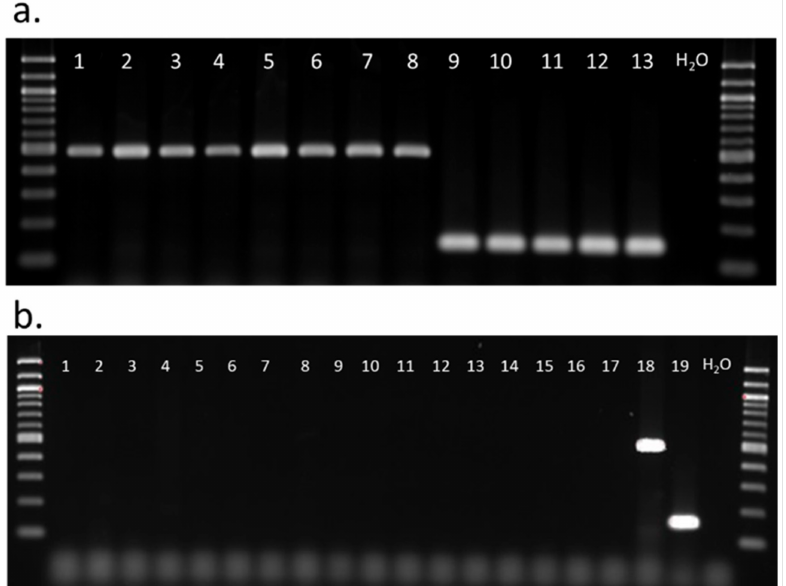
Figure 4. ( a ) Diagnostic polymerase chain reaction for DNA sequence-based identification of specimens of the S. festinus genotype from California (lanes 1–8) and the Southeastern United States (lanes 9–13). ( b ) Specificity of the diagnostic PCR against other Membracidae (lanes 1–4), Cercopidae (lanes 5–6), Fulgoroidea (lanes 7–8), Cicadellidae (lanes 9–14), Aphididae (lane 15), Aleyrodidae (lane 16), and Psylloidea (lane 17) compared to the S. festinus genotype from California (lane 18) and the Southeastern United States (lane